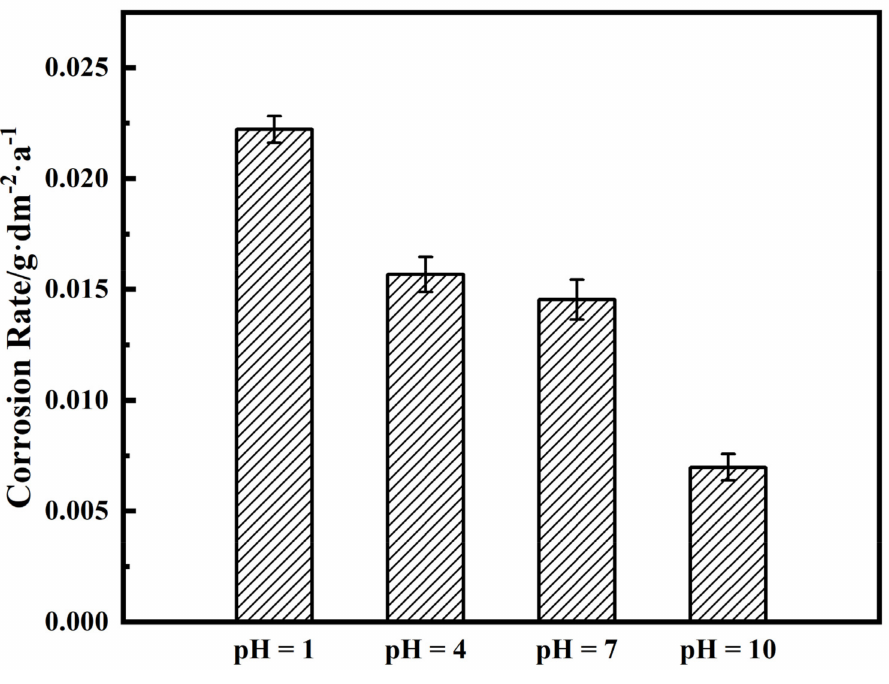
Figure 8. Corrosion rate of TA2 in simulated seawater with different pH values.